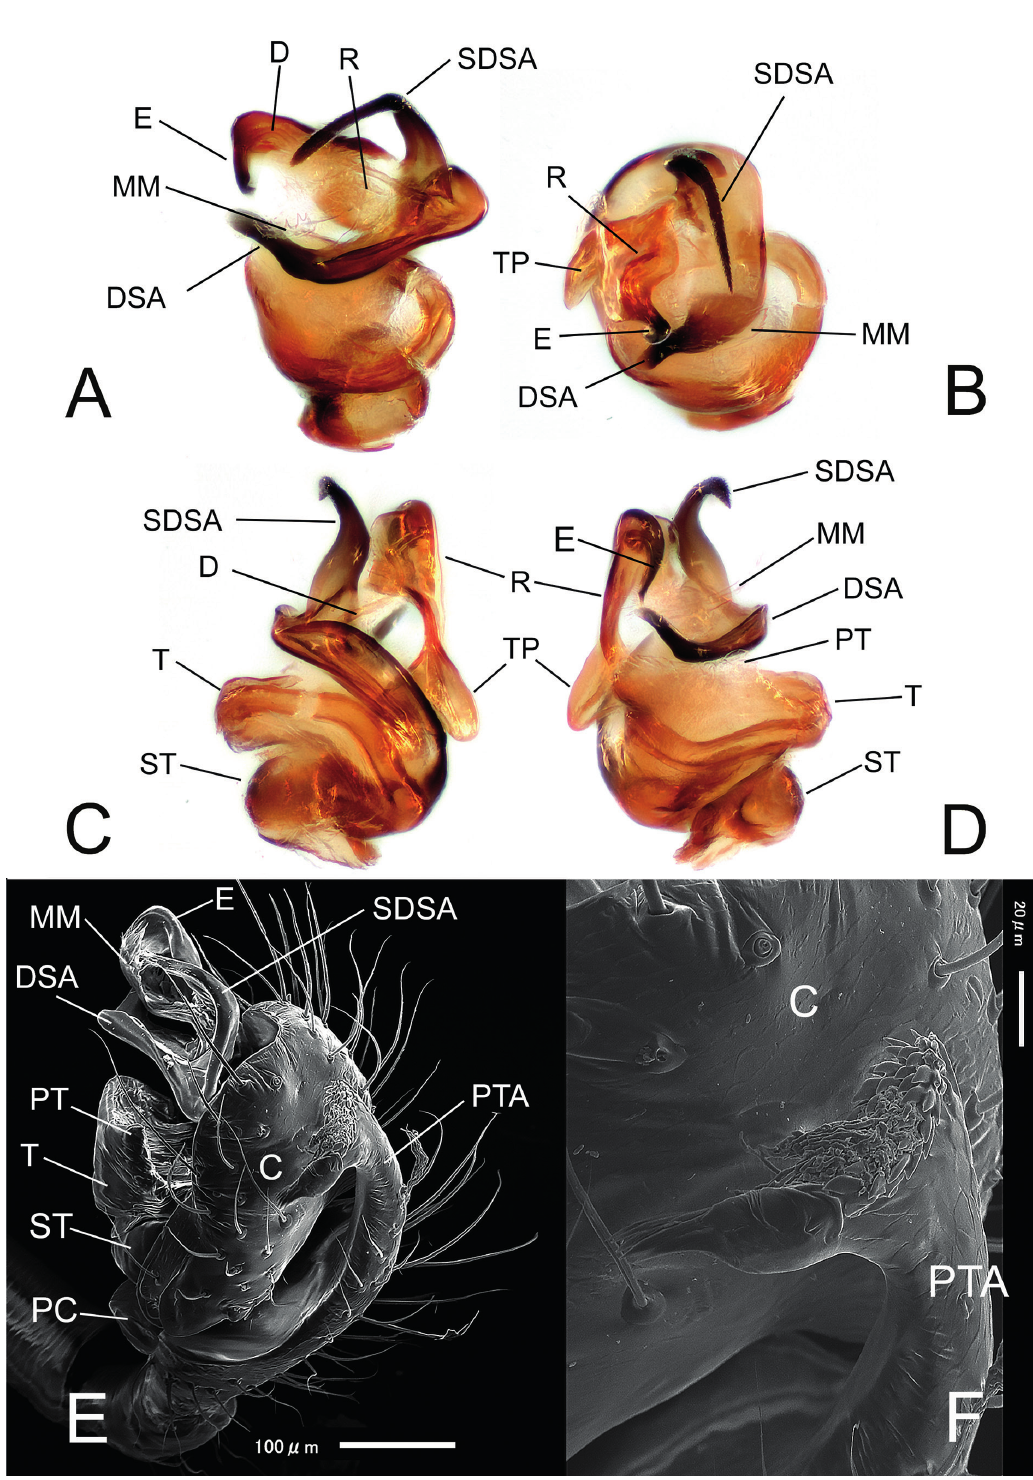
Fig. 4. Embolic division and details of the male palp of Nihonella chika gen. et. sp. nov. A . ♂, paratype (NSMT-Ar 20911), embolic division, ventro-retrolateral view. B . Ditto, frontal view. C . Ditto, dorsal view. D . Ditto, ventral view. E . ♂, paratype (NSMT-Ar 20910), palp under SEM microscope, antero- retrolateral view. F . Ditto, detail of the tip of the prolateral tibial apophysis. Abbreviations: see Material and